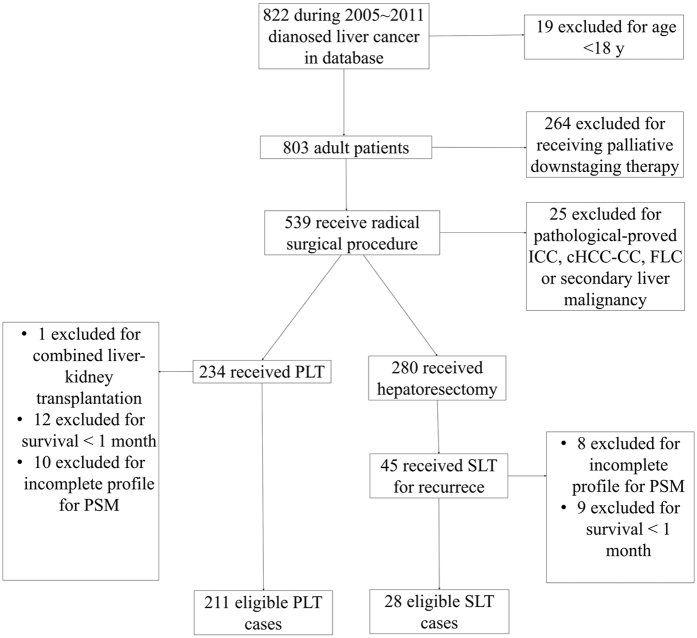
Patient flow diagram.